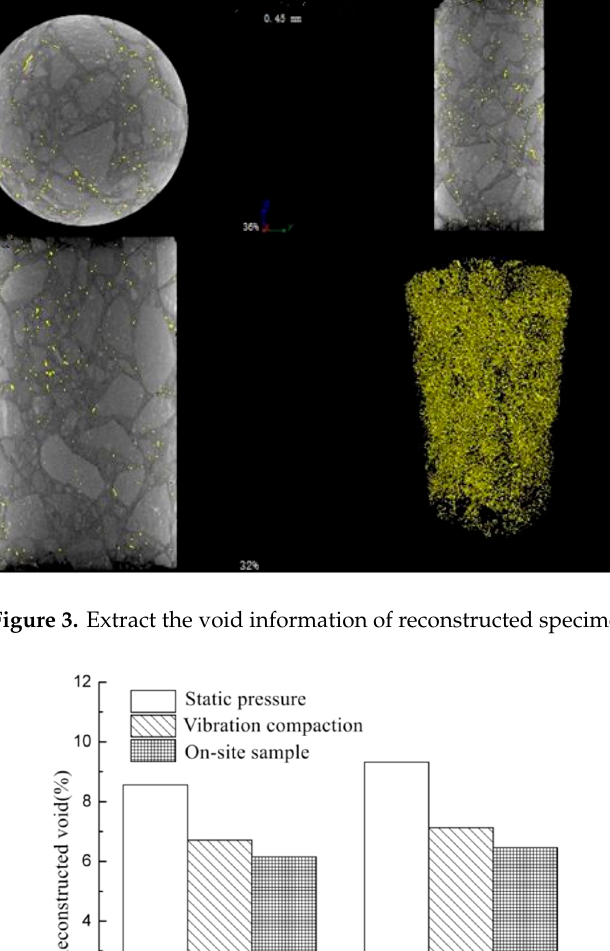
Figure 4. The reconstructed void of different molding mixtures.